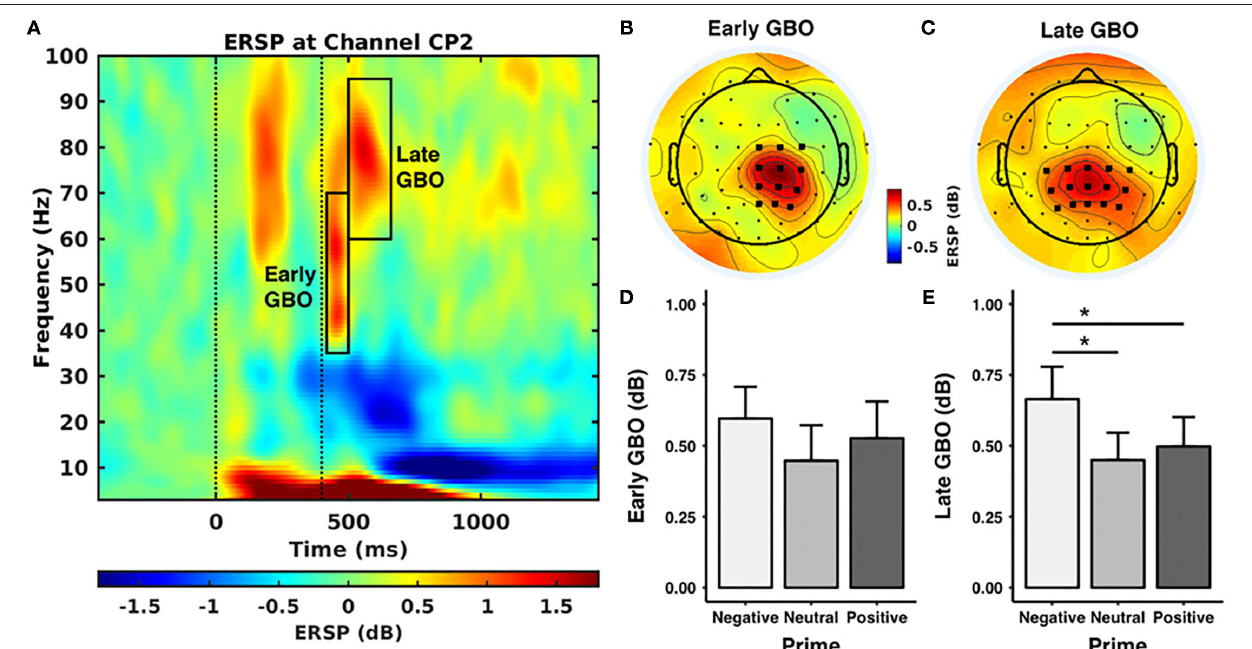
FIGURE 3 | Gamma band oscillations (GBOs). (A) Event-related spectral perturbation (ERSP) at CP2 across all the pictures and all the subjects. The first dashed line stands for the onset of the prime stimulus and the second dashed line represents the onset of the electrical stimuli. The black rectangles indicate the time-frequency windows of the early and late GBOs. (B,C) The scalp distribution of the early and late GBOs. The early GBO had a central distribution contralateral to the stimulus location and the late GBO had a centroparietal distribution. The bold black dots indicate the regions of interest used in the statistical analyses. (D,E) The ERSP value of the GBO for each prime valence. The late GBO showed a significant main effect of prime valence, while the early GBO did not show a significant main effect of prime valence. **p < 0.05.